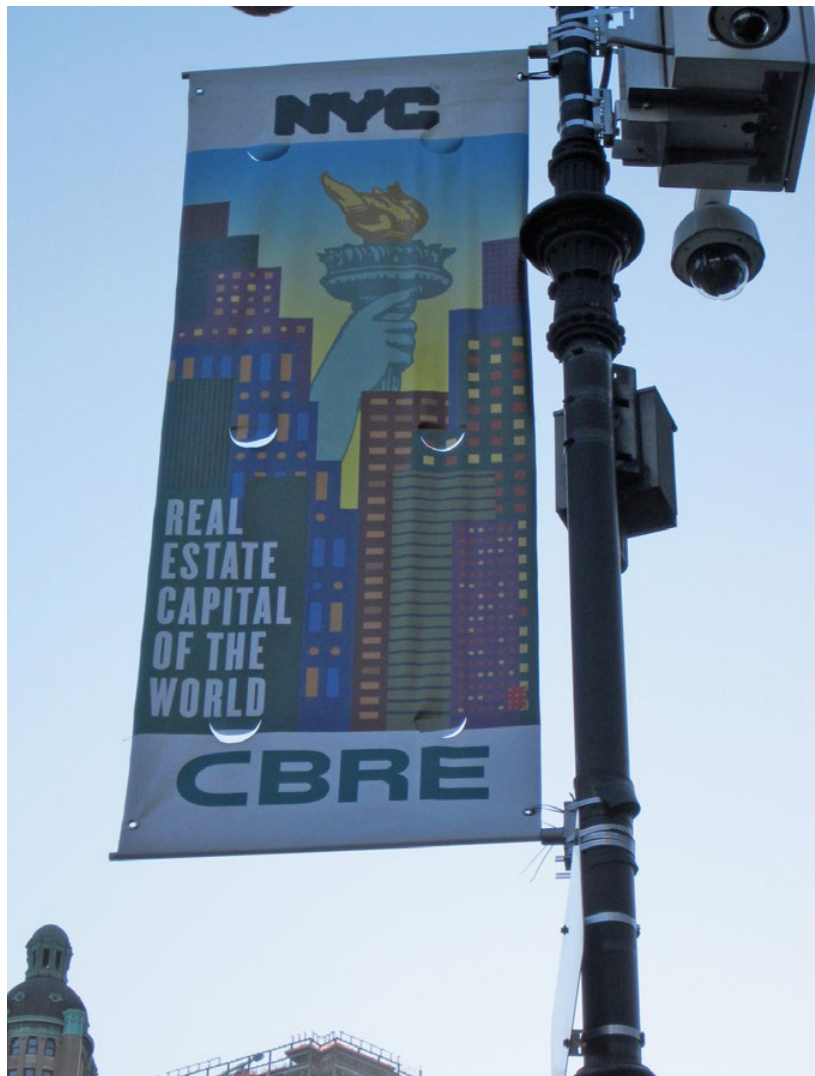
Figure 1. Cooper Square and the ‘Real Estate Capital of the